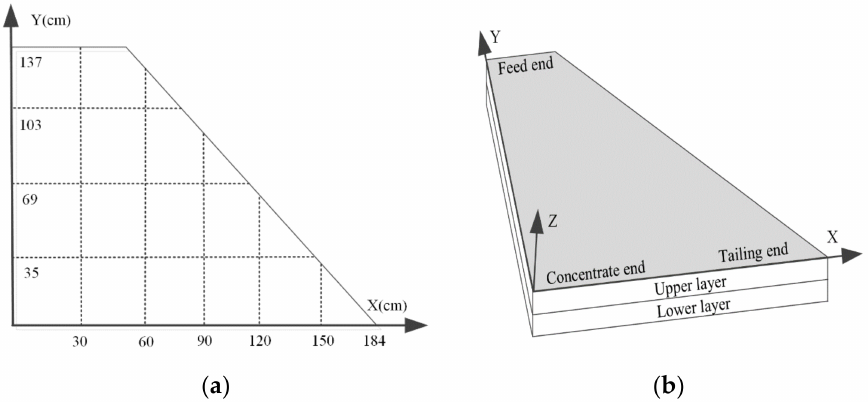
Figure 4. Separation bed spatial sampling coordinate system diagram. ( a ) Distribution of sampling points on the bed surface. ( b ) Spatial structure diagram of separation